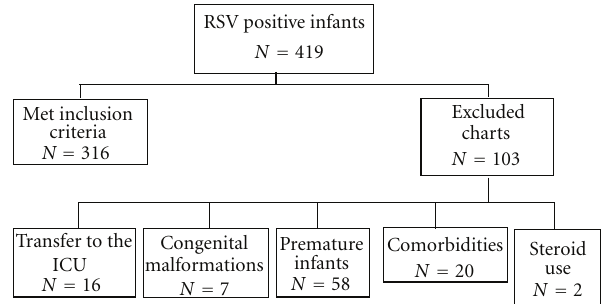
Figure 1: Selection of infants based on inclusion and exclusion